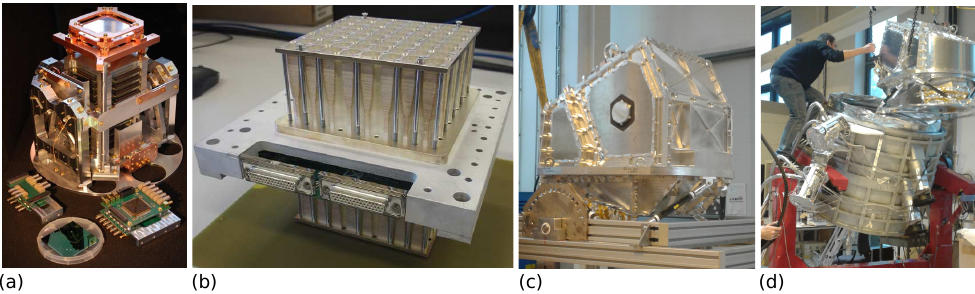
Figure 7. Status of the current QUBIC development. ( a ) The cryogenic section of the QUBIC detection chain; ( b ) the TD array of 64 + 64 back-to-back horns interfaced with their switches; ( c ) the integrated 1K box; ( d ) integration of the 1K box in the cryostat